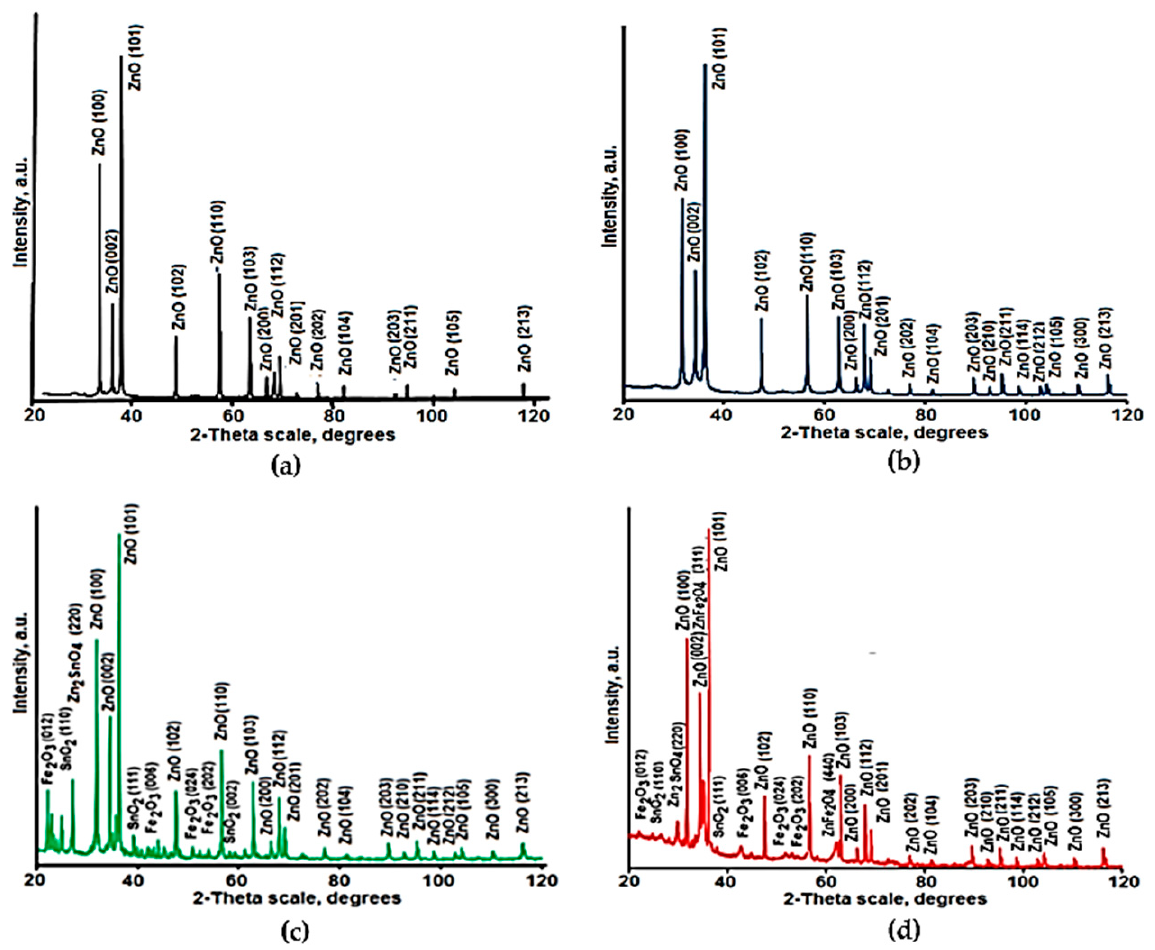
Figure 2. XRD patterns of samples 1 ( a ), 2 ( b ), 3 ( c ), 4 ( d ).